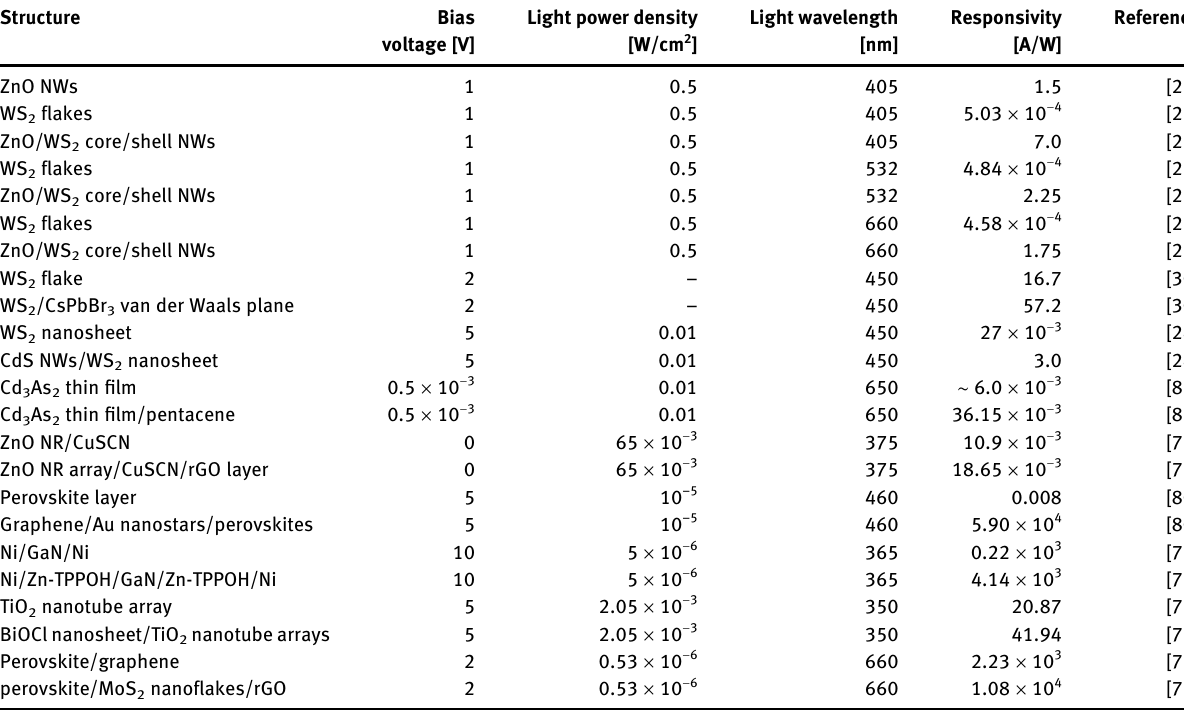
Table  : Summary of resistivity of nanowire/  D material hybrid materials and their counterparts.